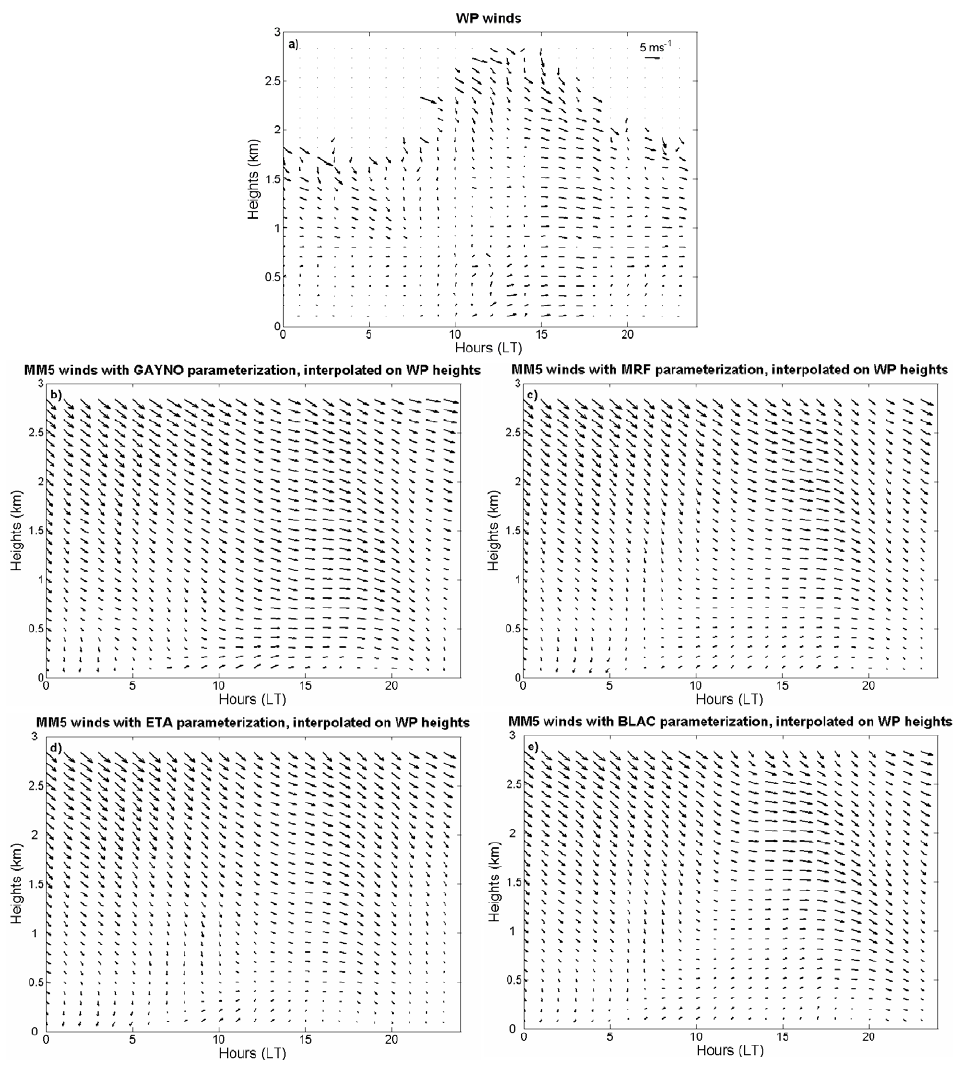
Fig. 11. Time-height evolution of the wind vector during the representative day, as observed by the wind profiler (WP) (Fig. 11a), and as predicted by the MM5, using different PBL parameterizations: GAYNO (Fig. 11b), MRF (Fig. 11c), ETA (Fig. 11d), and BLAC (Fig. 11e).